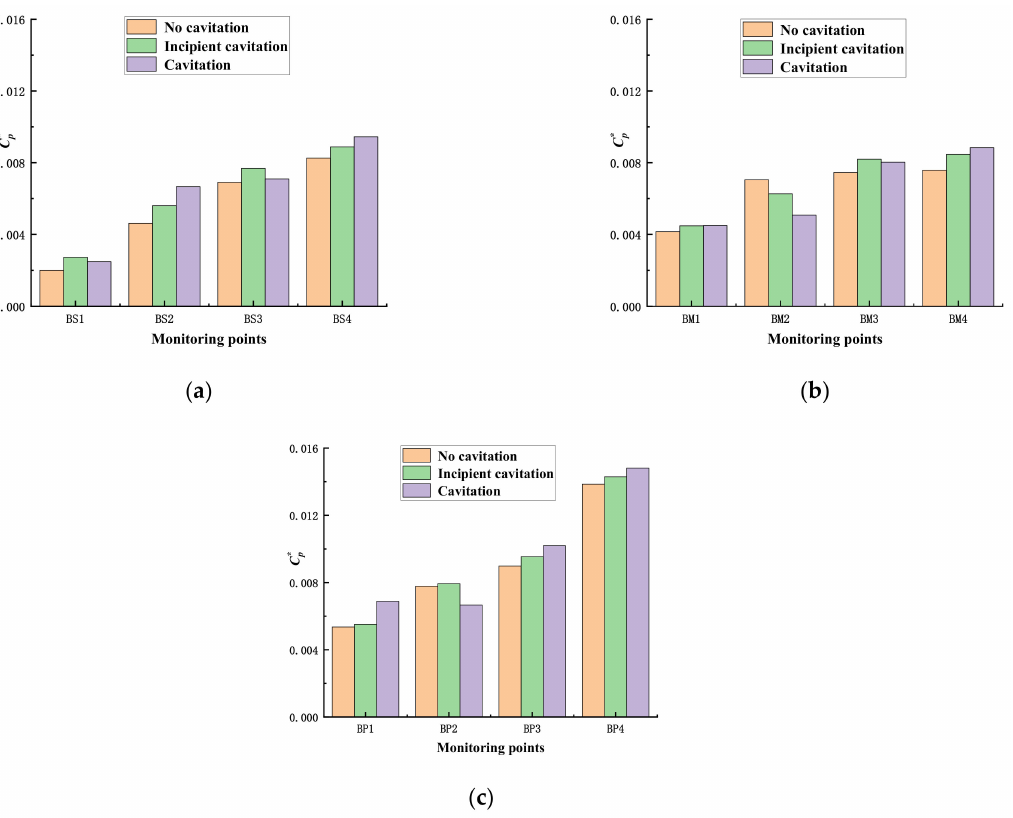
Figure 15. The maximum amplitude of pressure fluctuations in the impeller. ( a ) Blade suction surface; ( b ) Middle of the flow channel; ( c ) Blade pressure